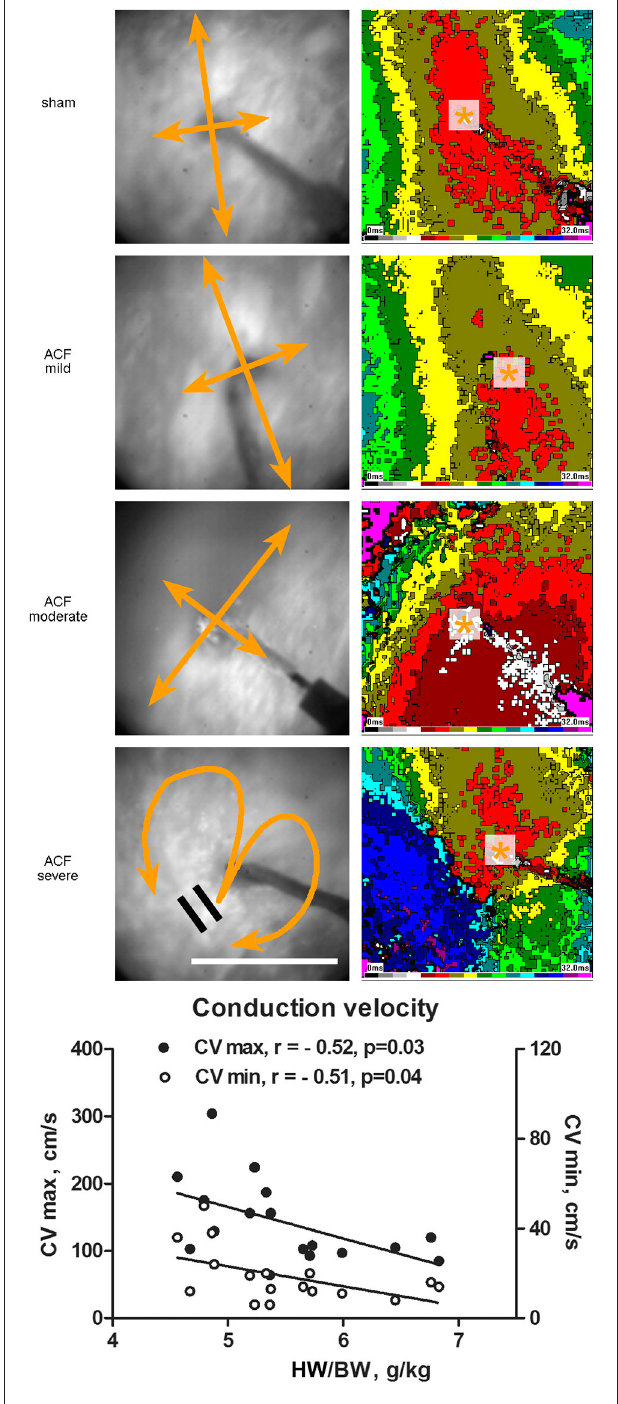
FIGURE 2 | Epicardial activation patterns of the left ventricle during electrical pacing. Representative activation maps constructed at 2 ms intervals from the LV mid-portion lateral wall (field of view 8 × 8 mm) are shown for each group. Pacing cycle length is 300 ms in all cases. Asterisk indicates the site or pacing, bidirectional arrows the direction of maximal and minimal conduction velocity. Scale bar 5mm. The graph below shows correlation between the maximal and minimal conduction velocity and phenotype severity. r, Pearson’s correlation coefficient. Line represents linear